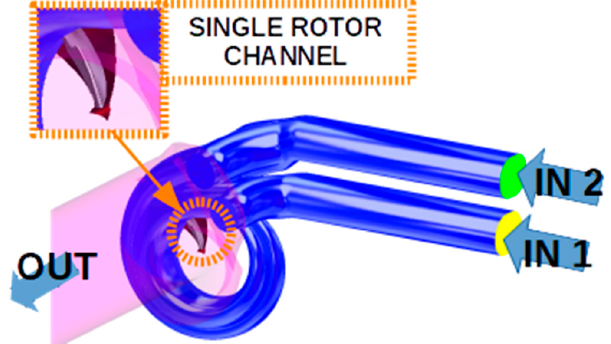
Figure 3. CFD model.